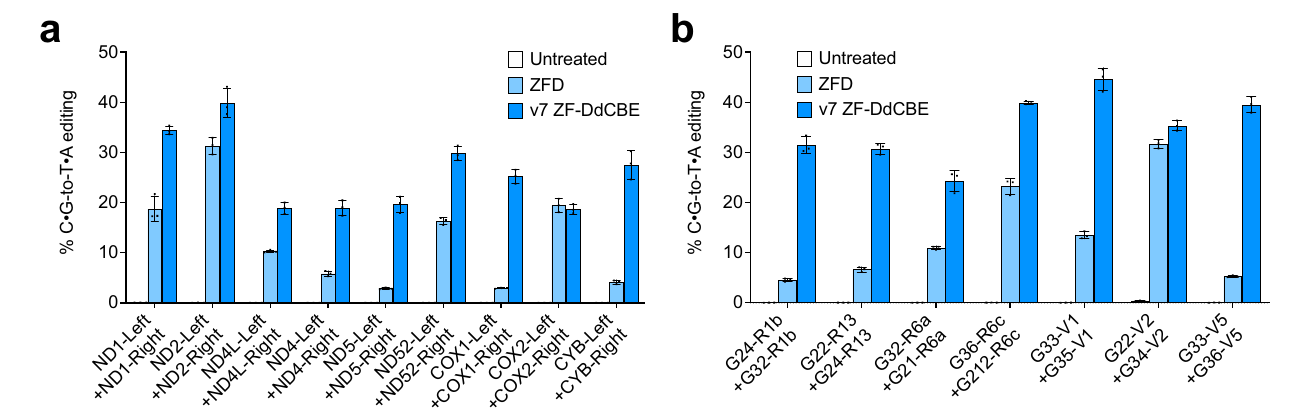
Fig. 2 | Optimized ZF-DdCBEs display increased base editing ef fi ciency over ZFDs in mitochondria. a , b Comparison of mitochondrial DNA base editing ef fi - ciencies of HEK293T cells treated with either ZFD or optimized ZF-DdCBE pairs at genomictargetsites chosen by ( a )Limetal. 29 ,or ( b )by this study.For( a , b )values